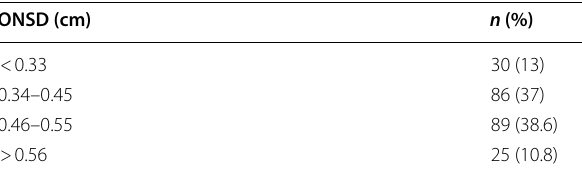
Table 3 Optic nerve sheath diameter (ONSD) distribution in four groups according to normality reported in other populations ONSD (cm)